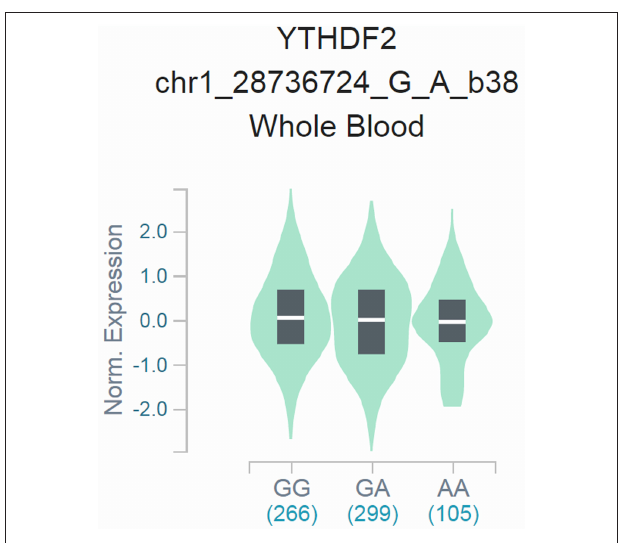
FIGURE 1 | Functional relevance of rs3738067 A > G to YTHDF2 expression in GTEx database. The rs3738067A allele had a significant association with YTHDF2 level alteration in the whole blood [ P = 1.9*10 − 5 , normalized effect size (NES) =